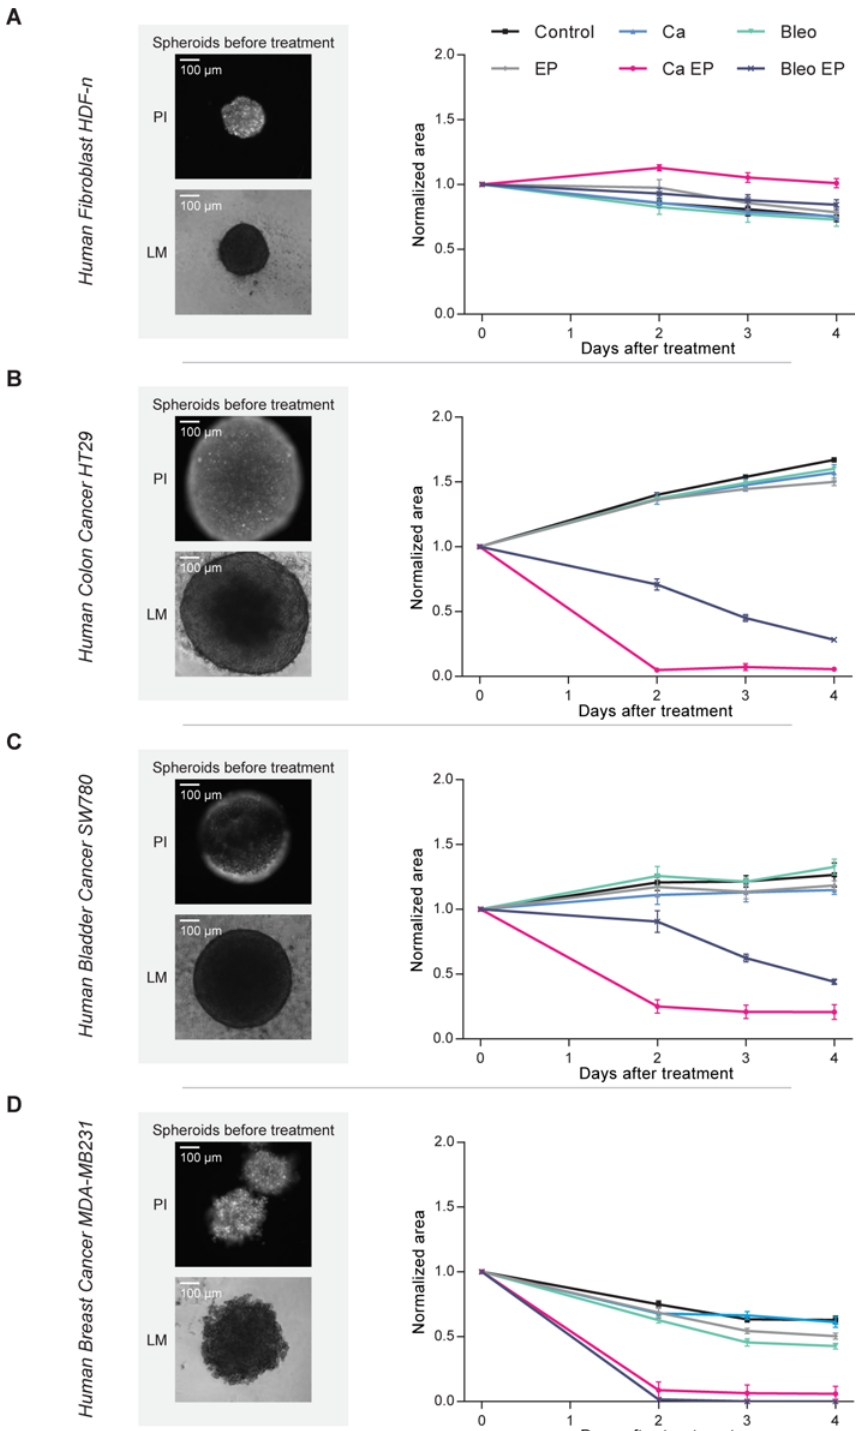
Fig 1. Spheroid size. Size measurements of human normal dermal fibroblast (A), colon cancer (B), bladder cancer (C), and metastatic breast cancer (D) spheroids. Left panel: representative fluorescence microscopy images of a spheroid just after electroporation (8 pulses of 100 μ s, 1000 V/cm, and 1 Hz) in buffer containing propidium iodide (PI) to visualize electropermeabilized cells and light microscopy images of another spheroid just before treatment (LM). Right panel: Growth curves of the spheroids after treatment with respectively